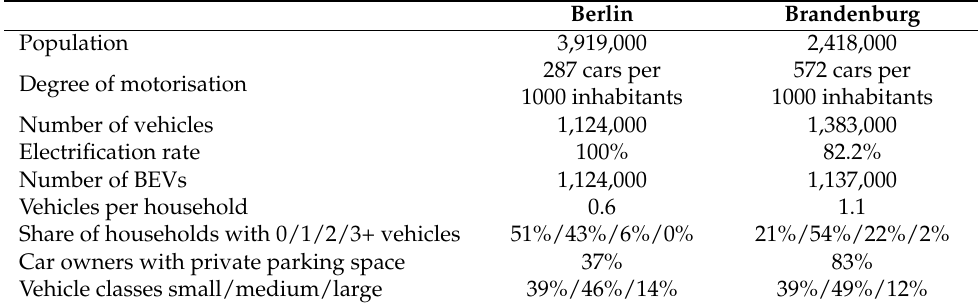
Table 1. Comparison of the electric passenger car development of Berlin and Brandenburg in 2040